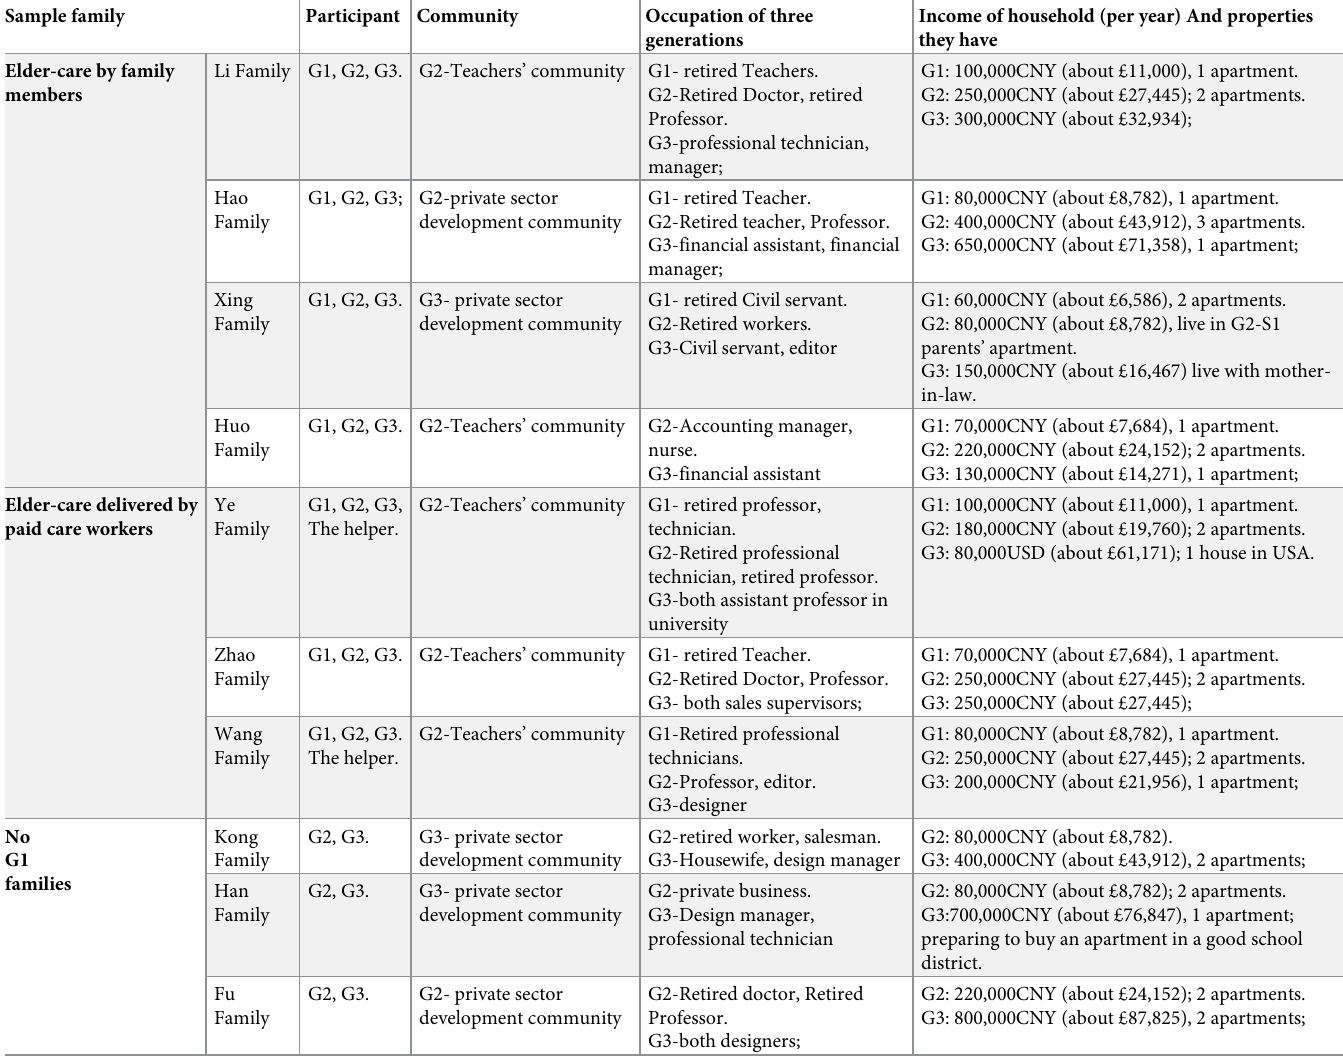
Table 2. Families divided into types of care